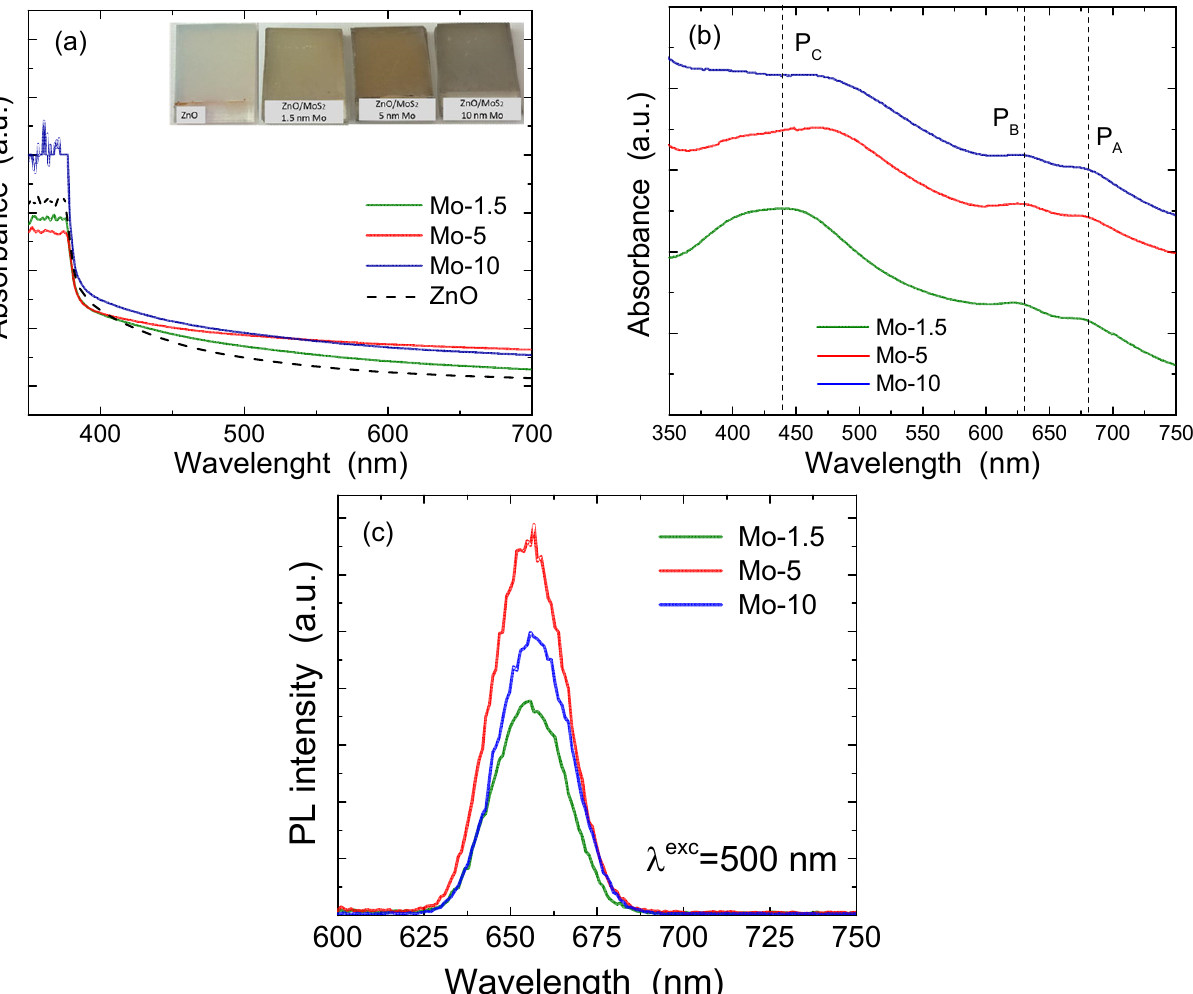
Figure 4. ( a ) UV-vis absorption spectra of the bare ZnO and ZnO/MoS 2 heterostructures; the inset shows optical images of the samples. ( b ) Absorption spectra of MoS 2 films deposited on FTO glass substrate. ( c ) Photoluminescence spectra of ZnO/MoS 2 heterostructures (excitation at 500 nm).